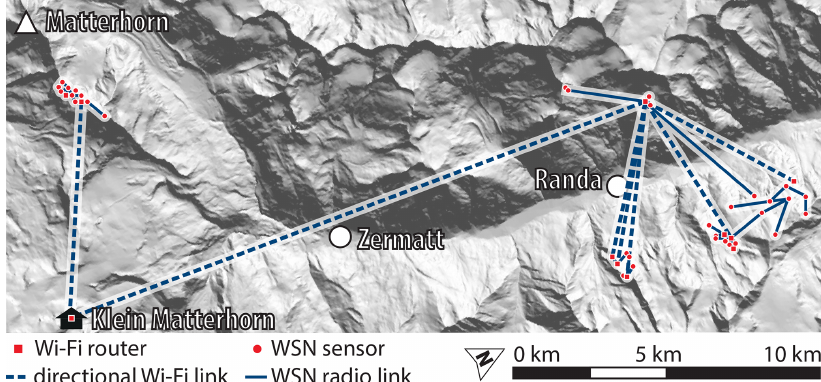
Figure A6. Wireless LAN (WLAN) backbone and fine distribution of wireless connectivity to all sensor locations in the Matter Valley. The basis for such connection is a WLAN access point located at the cable car station of the Klein Matterhorn 3883ma . s . l . about 6.5km away, where the network is attached to a local Internet service provider using glass fibre. In a previous publication, Weber et al. (2019a) provided a more comprehensive and detailed description of the technology of the WSN.